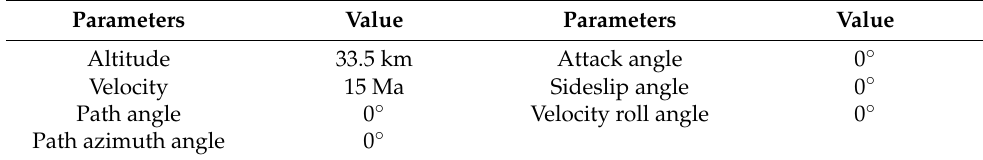
Table 2. Initial Flight Status.